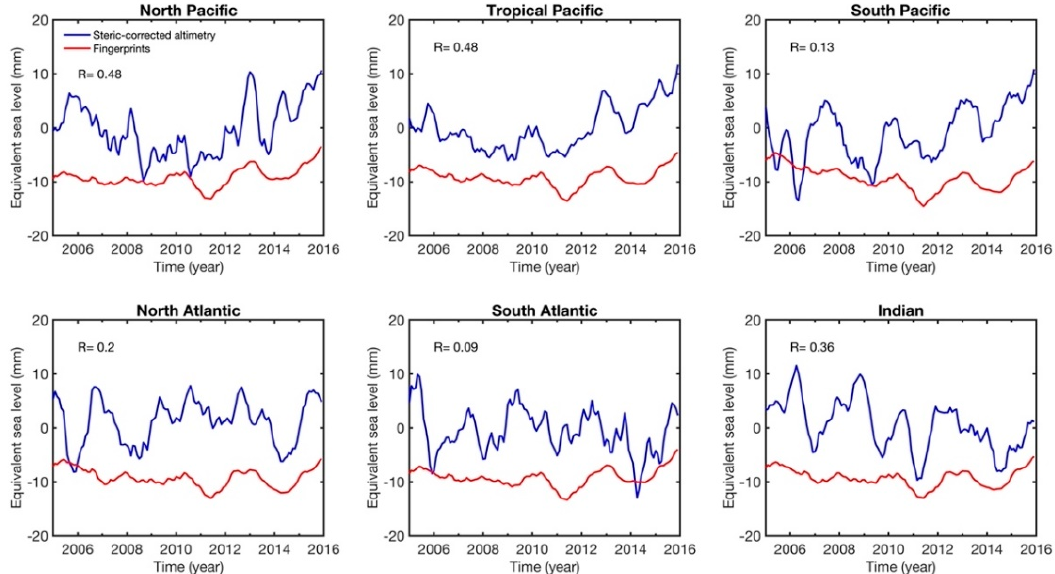
Figure 7. Regionally averaged time series of steric-corrected altimetry-based sea-level (in blue) and absolute sea-level fingerprints (in red) for 6 ocean basins: North Pacific (65 ◦ N–30 ◦ N), Tropical Pacific (30 ◦ N–30 ◦ S), South Pacific (30 ◦ S–50 ◦ S), North Atlantic (65 ◦ N–0 ◦ ), South Atlantic (0 ◦ –65 ◦ S) and Indian ocean (up to 50 ◦ S); for January 2005–December 2015. A 6 month smoothing was applied to the basin averages. The R number represents the Pearson correlation between both variables in the corresponding ocean basin.